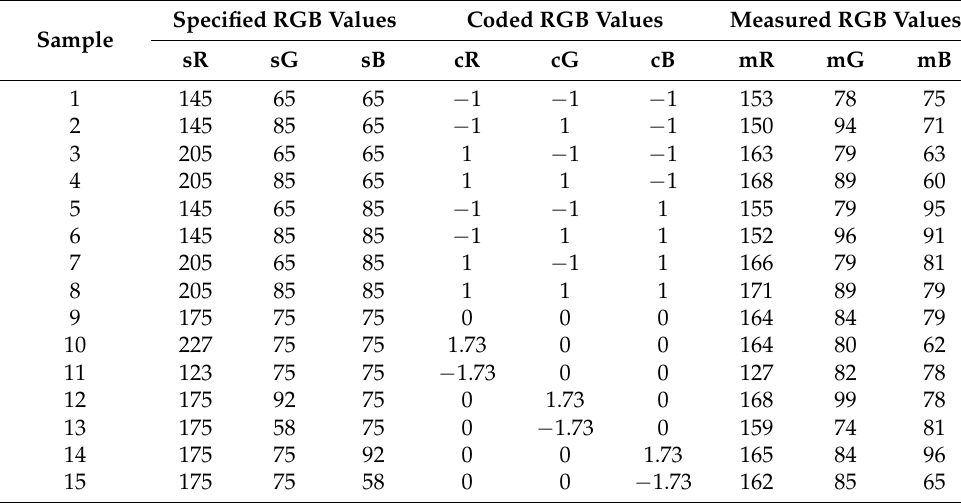
Table A2. CCD matrix and results for Case